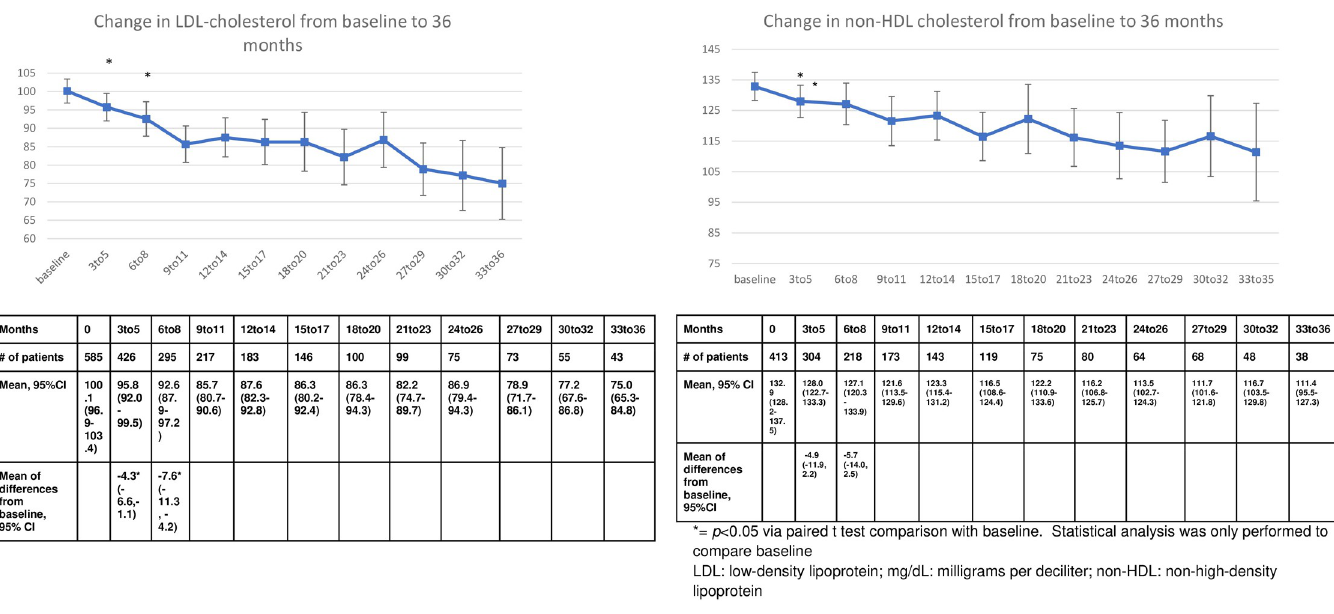
Fig 4. Change in LDL from baseline to 36